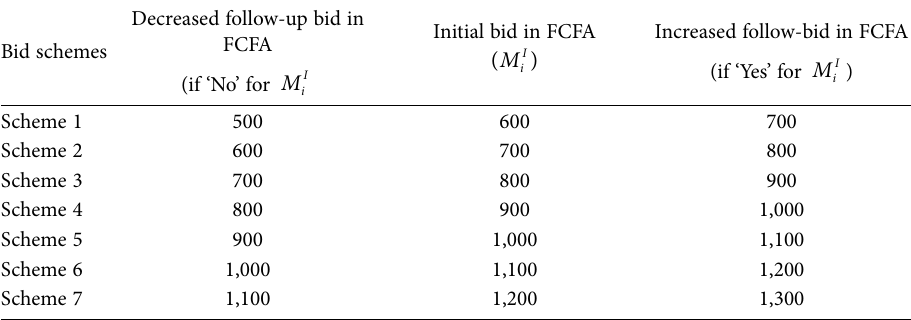
Table 1. Random bid schemes used in the double-bounded contingent valuation